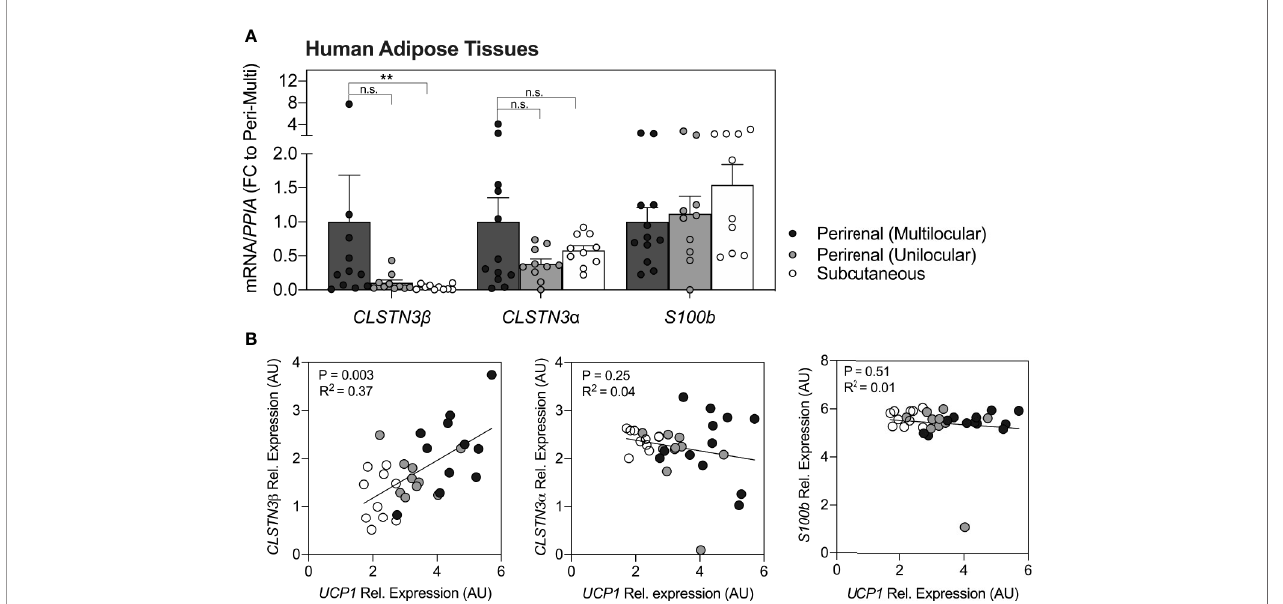
FIGURE 1 | CLSTN3 b is enriched in human multilocular brown adipose tissue and correlates with UCP1 expression across fat depots. (A) Relative mRNA expression of CLSTN3 b , CLSTN3 a and S100b in human multilocular or unilocular perirenal brown fat and subcutaneous white fat. Data represent (fold change) means ± SEM. (B) Correlational analysis of all three genes vs. UCP1 across human fat depots (logarithmic values are plotted). Statistical differences are based on one-way-ANOVA with Kruskal Wallis post-test (A) or linear regression (B) . Asterisks: **p < 0.01.